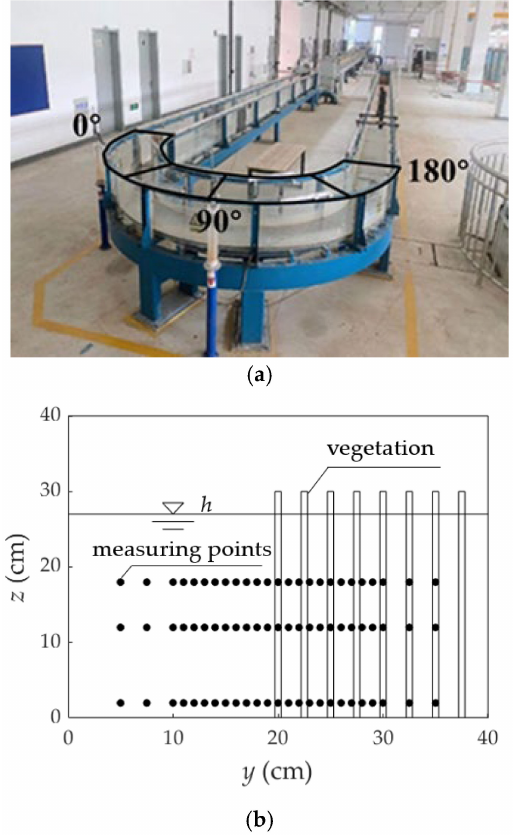
Figure 2. Flume picture and distribution of measuring points. ( a ) 180 ◦ U-shaped curve flume. ( b ) The schematic of the measuring points (as mentioned above, some vegetation stems are removed for ADV